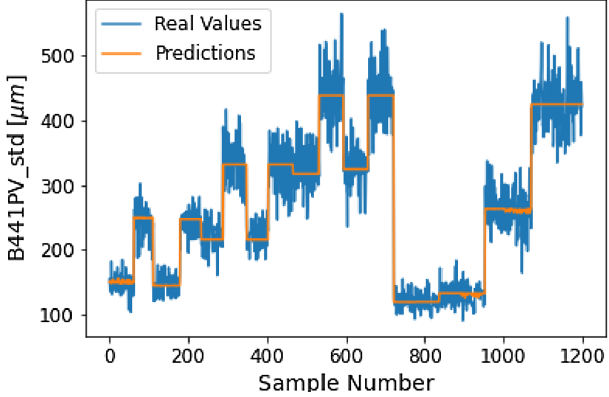
Fig. 21. The x -axis represents the test dataset, which consists of 1200 data points (20% of the total dataset size). The predictions (gold) appear centered in the BPM real values (blue). The groups in Fig. 19 represent BPM measurements over the same beam and corrector configu- ration (i.e., fixed bunch charge and H = V 125 corrector currents). These groups consist of ∼ 60 data points since we took 300 shots for each beam and corrector